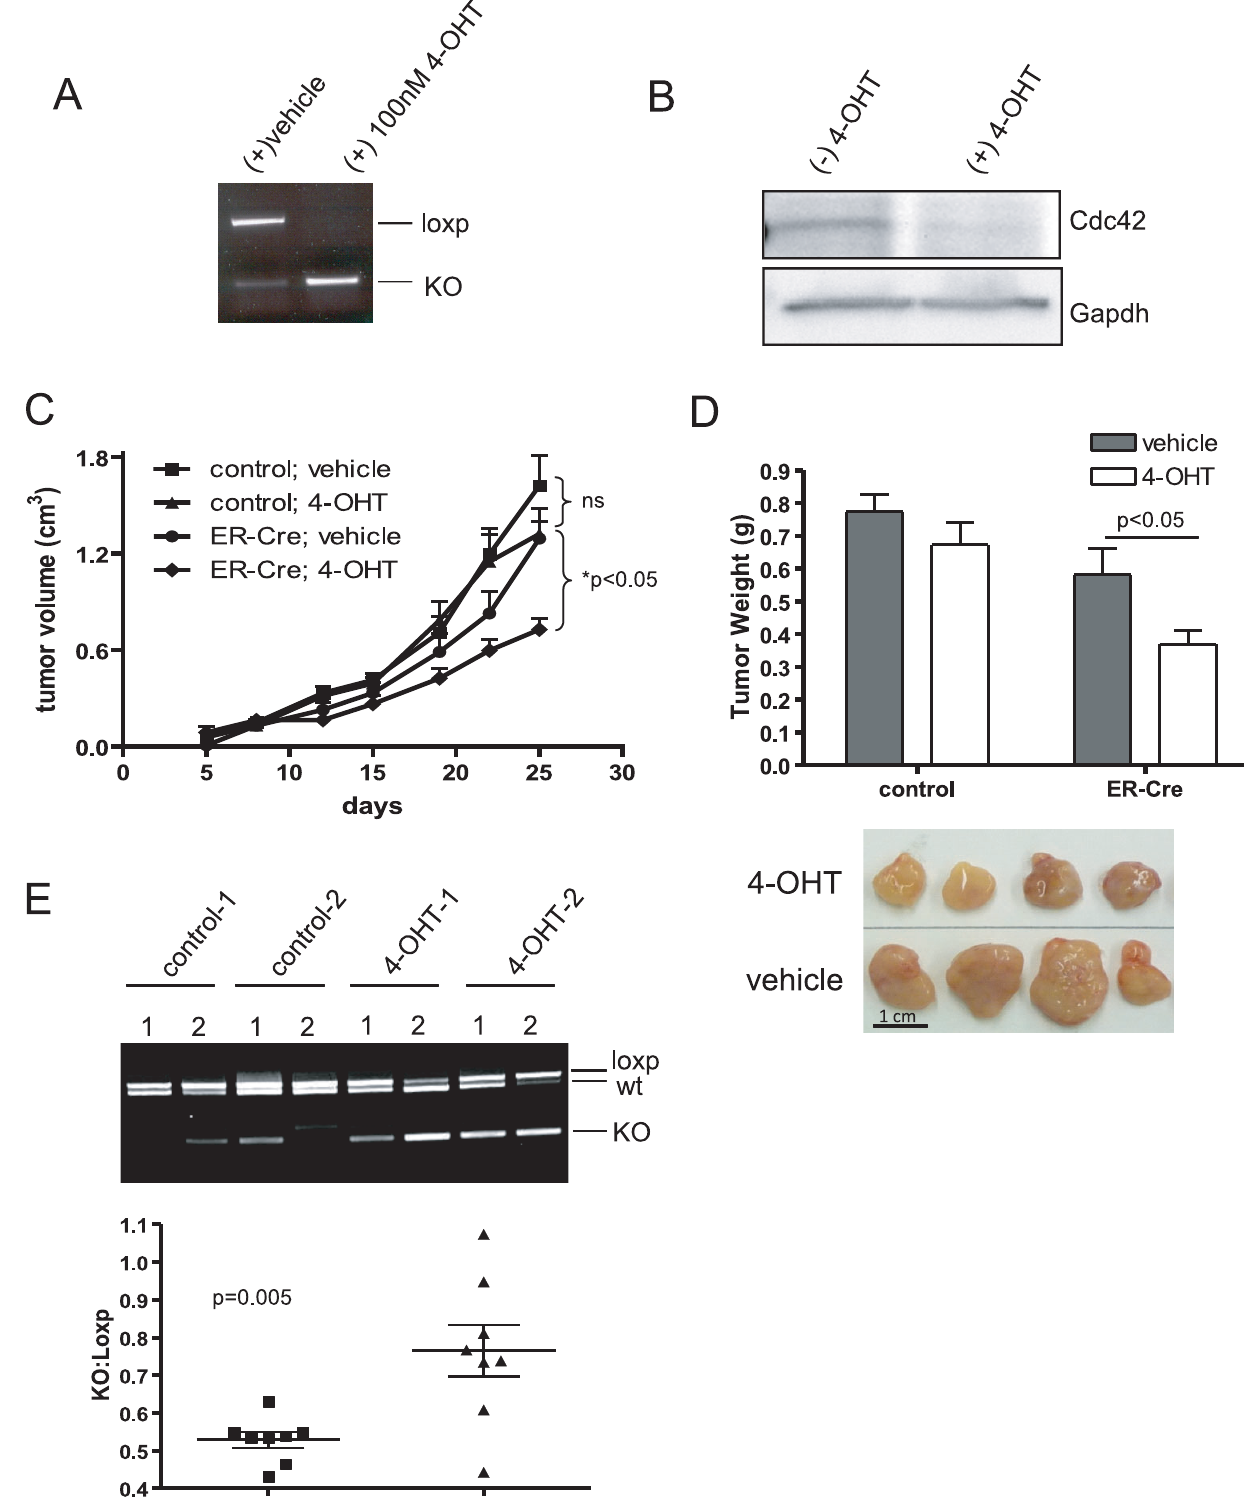
Figure 7. Cdc42 deletion in HRasV12-driven tumors inhibits tumor growth. ( a ) HRasV12; Cdc42 f/f cells were transduced with retroviral ER- Cre and selected with puromycin. Antibiotic resistant cells were pooled and treated in culture with 4-OH Tamoxifen (4-OHT) or vehicle. Recombination at the cdc42 locus was determined by PCR. ( b ) Cell lysates were isolated from cells cultured in the presence and absence of 4-OHT. Western blotting was performed to determine Cdc42 protein levels following Tamoxifen-induced recombination. ( c ) HRasV12; ER-Cre; Cdc42 f/f and HRasV12; Cdc42 f/f cells were injected into the flanks of immunocompromised nude mice. Five days post-injection, palpable tumors had formed and